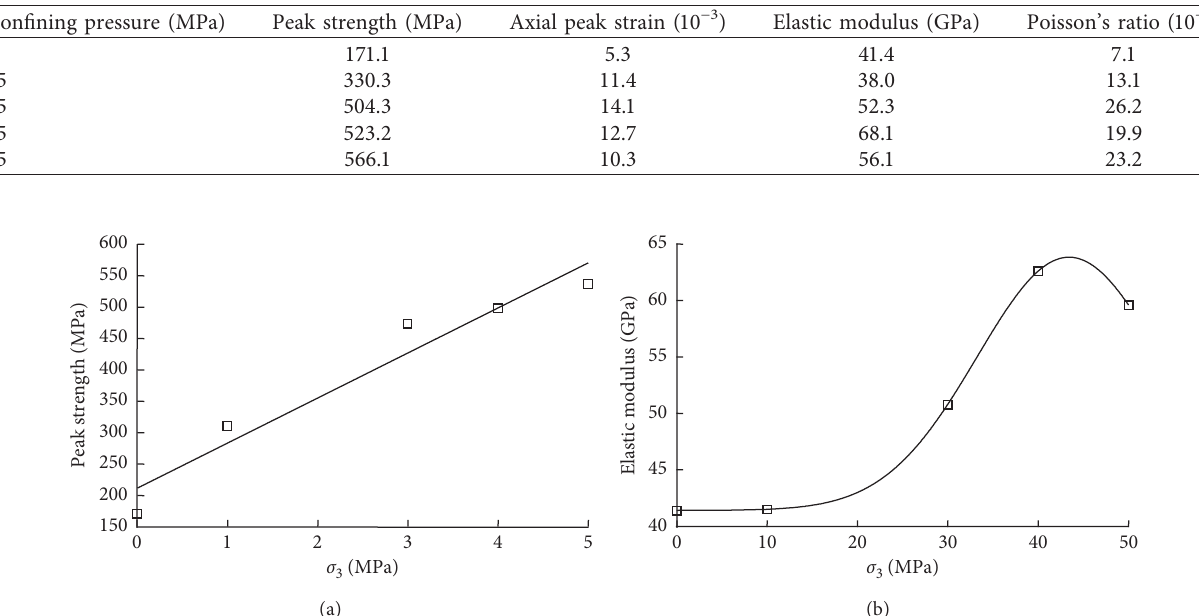
Table 3: Conventional triaxial peak strength under various confining pressures.